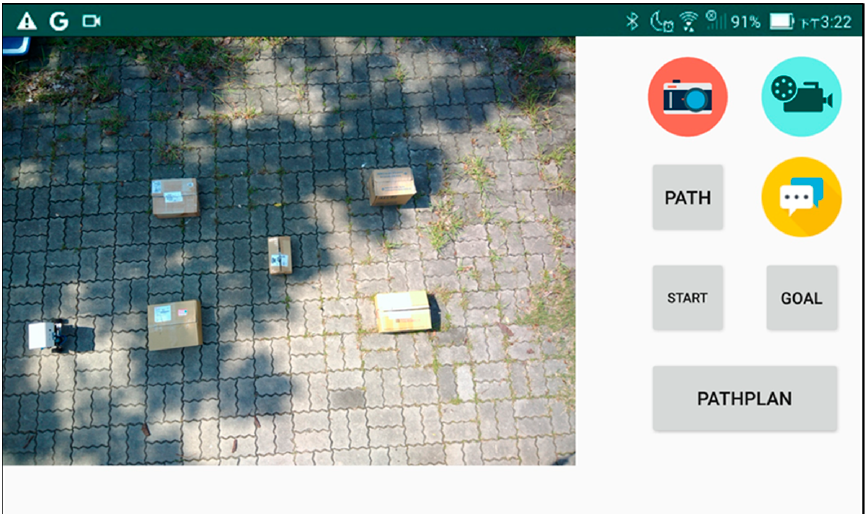
Figure 5. UAV interface: ( a ) Initial display of UAV interface; ( b ) Video streaming/photo shooting interface.